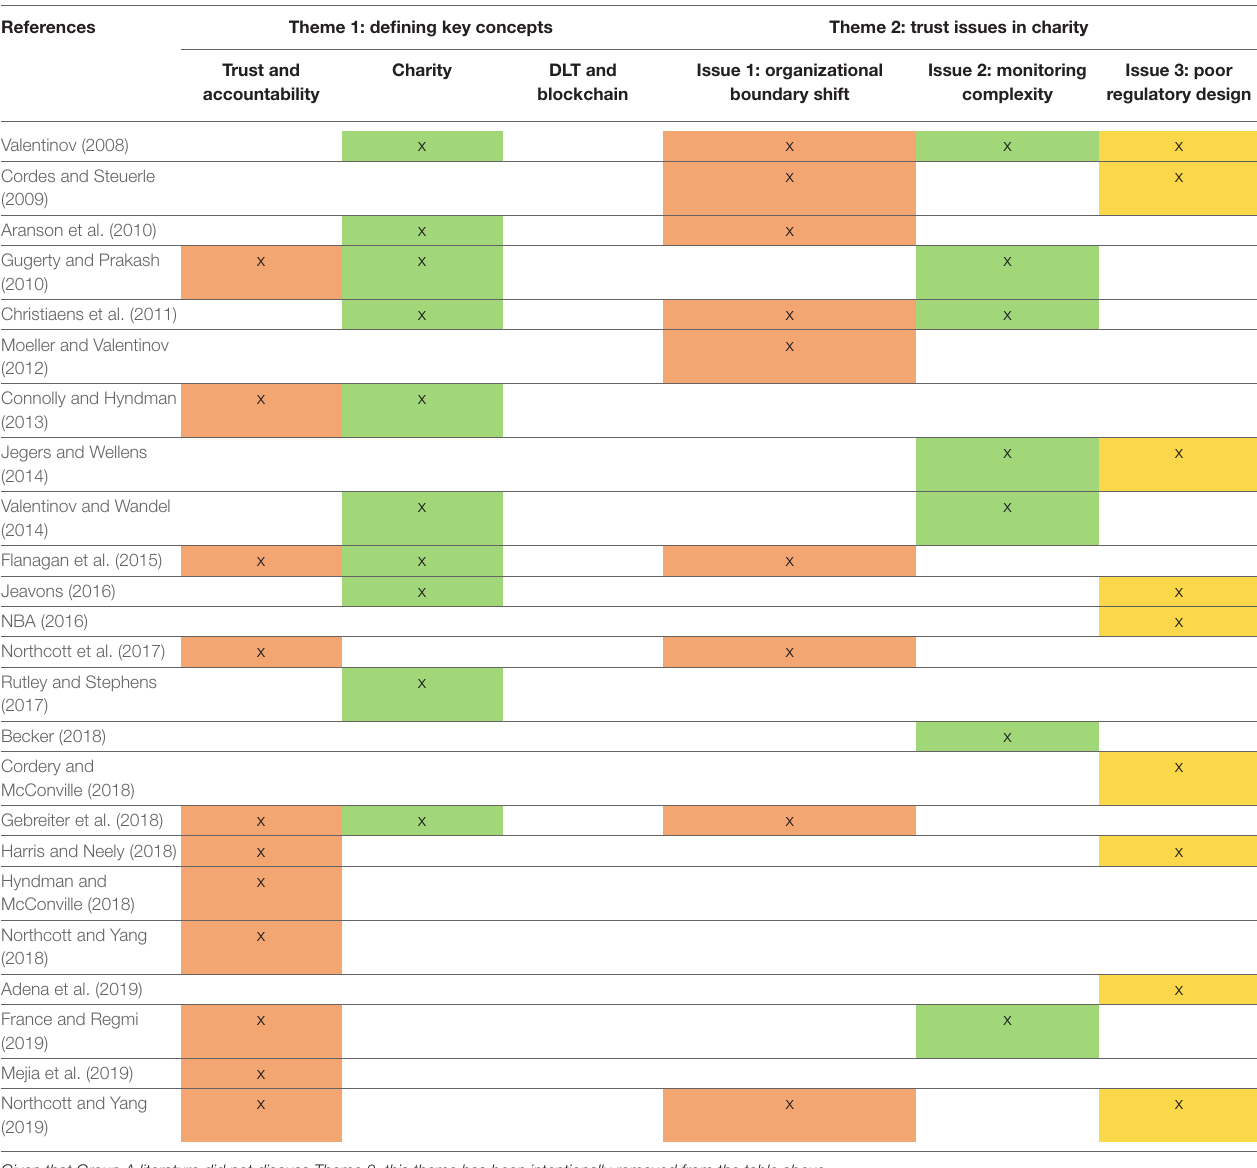
TABLE 4 | Thematic analysis of Group A